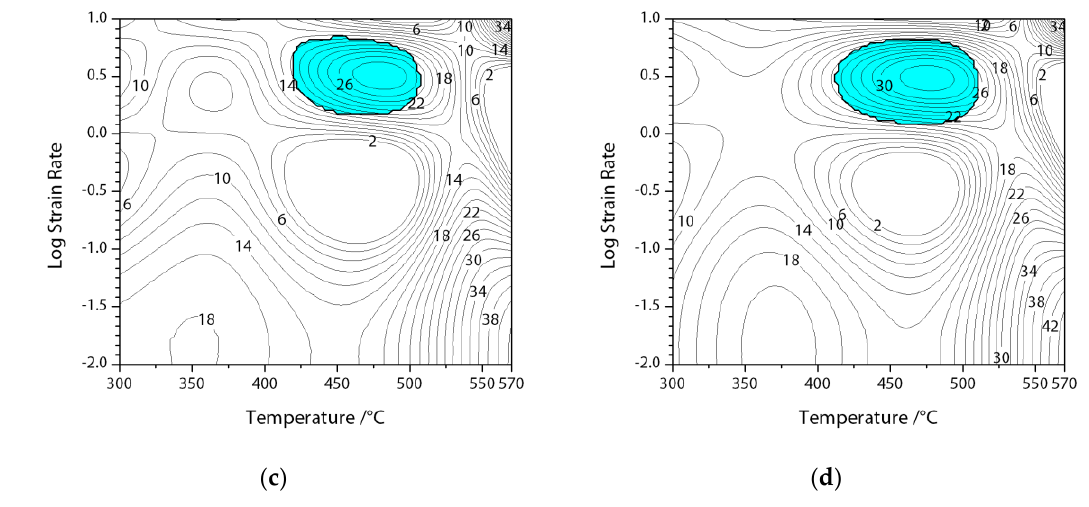
Figure 11. Processing maps based on the dynamic material model for Al 1080 powder extruded with direct press: ( a ) at strain 0.1, ( b ) at strain 0.2, ( c ) at strain 0.3 and ( d ) at strain 0.6.